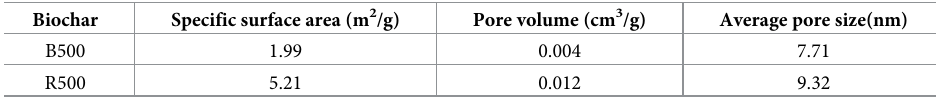
Table 1. Pore structure of biochars by the N 2 /BET method.